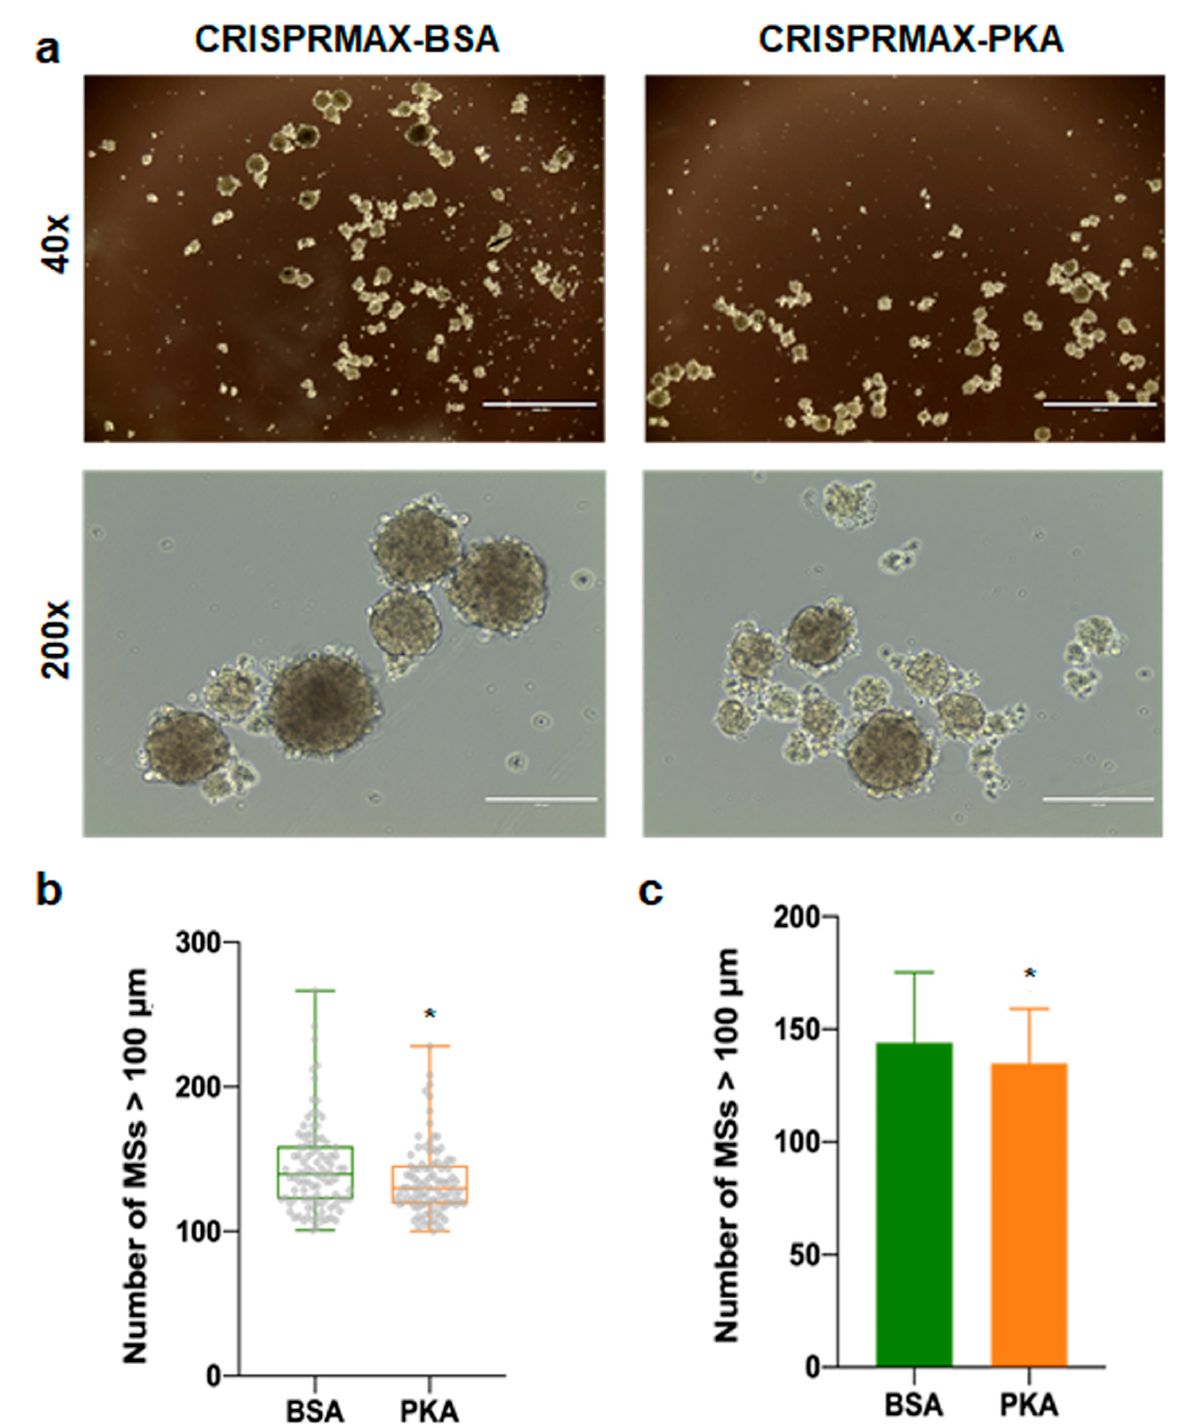
Figure 6. Mammosphere formation analysis of cells after CRISPRMAX-PKAs or CRISPRMAX-BSAs delivery. ( a ) Typical bright-field images of MSs were taken for each group (CRISPRMAX-PKAs and CRISPRMAX-BSAs) 1 week after culturing in mamosphere culture medium; for 40 × and 200 × magnification, the scale bar was 1000 and 200 µ m, respectively. ( b ) Whisker-box plot of the number of MSs (diameter > 100 µ m) for the CRISPRMAX-BSAs-delivered group and CRISPRMAX-PKAs-delivered group. ( c ) The bar graph of the number of MSs (diameter > 100 µ m) for the CRISPRMAX-BSAs-delivered group and CRISPRMAX-PKAs-delivered group. The number of MSs in the PKA group was significantly lower compared with the BSA group, p = 0.0214, * p < 0.05. Data were presented as Mean ± SD.